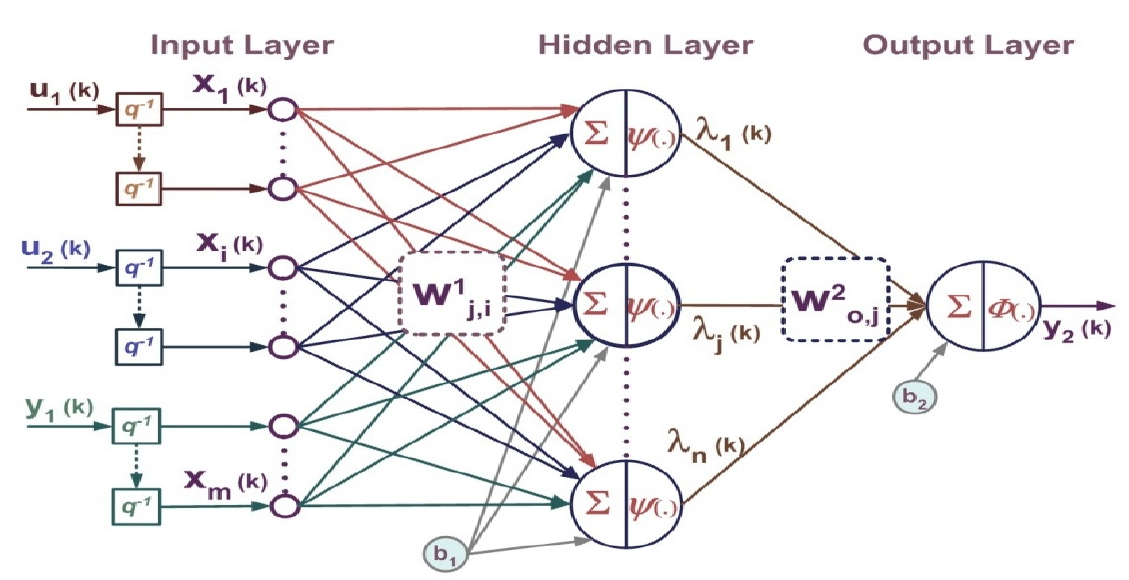
Figure 8. Implemented MISO NARX block diagram (series-parallel).